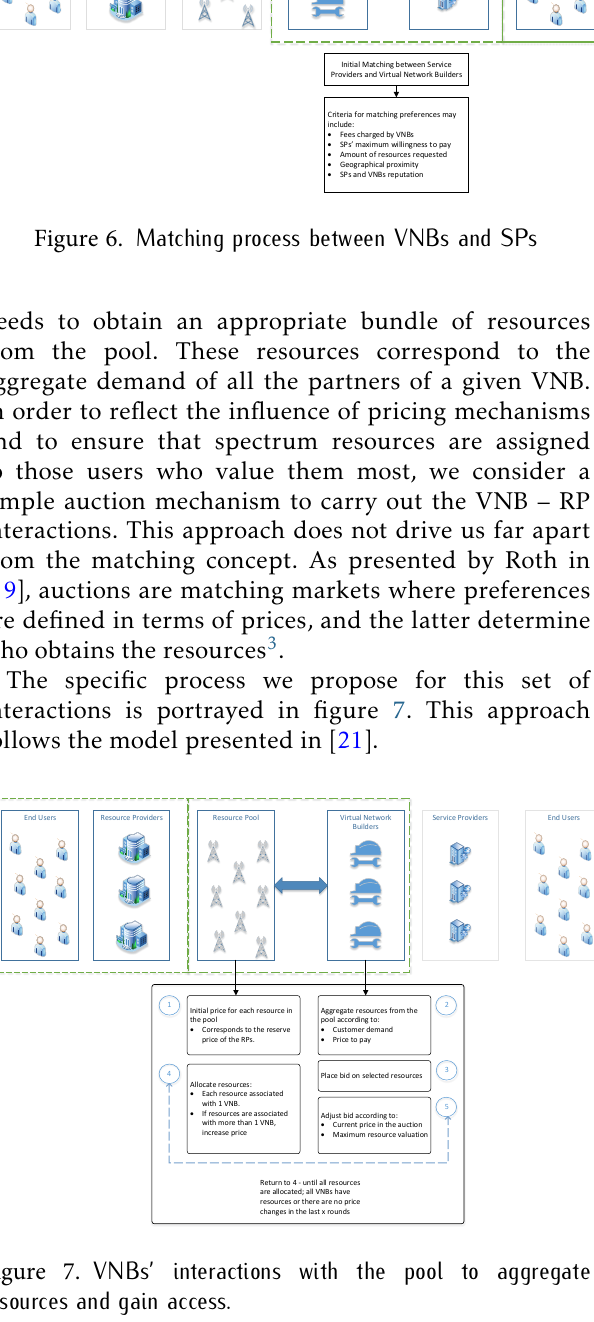
Figure 6. Matching process between VNBs and SPs